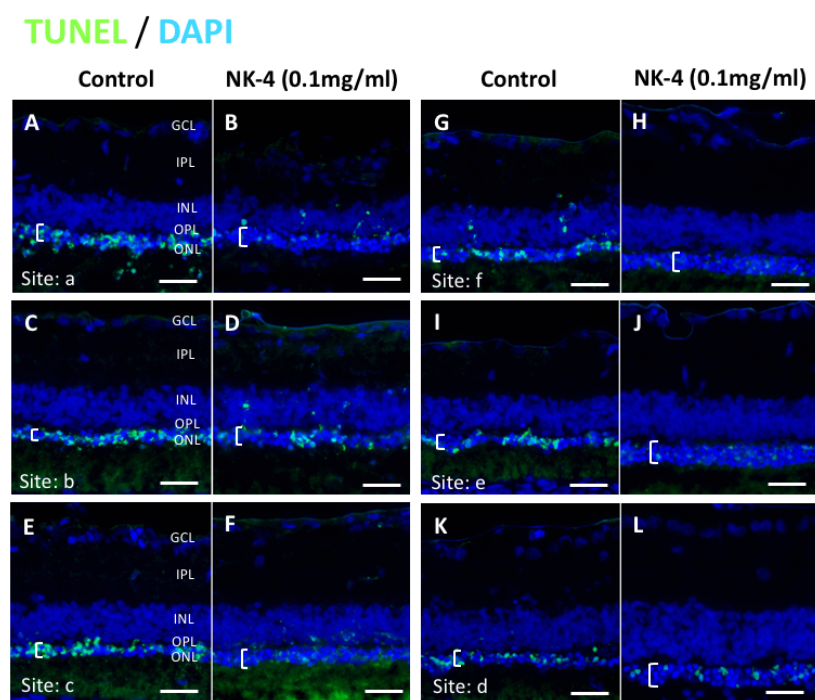
Figure 4. TUNEL staining of retinal sections at the concentration of 0.1 mg/mL NK-4 (this figure shows the condition of the entire retina in one RCS rat). The thickness of the ONL (white brackets) was thicker in the retina of NK-4-injected eyes, compared with control eyes. Cell nuclei were counterstained with DAPI (blue). Pair groups: ( A ) vs. ( B ), ( C ) vs. ( D ), ( E ) vs. ( F ), ( G ) vs. ( H ), ( I ) vs. ( J ), ( K ) vs. ( L ). ONL, outer nuclear layer; INL, inner nuclear layer; OPL, outer plexiform layer. White brackets represent the ONL. Scale bar = 20 μ m.